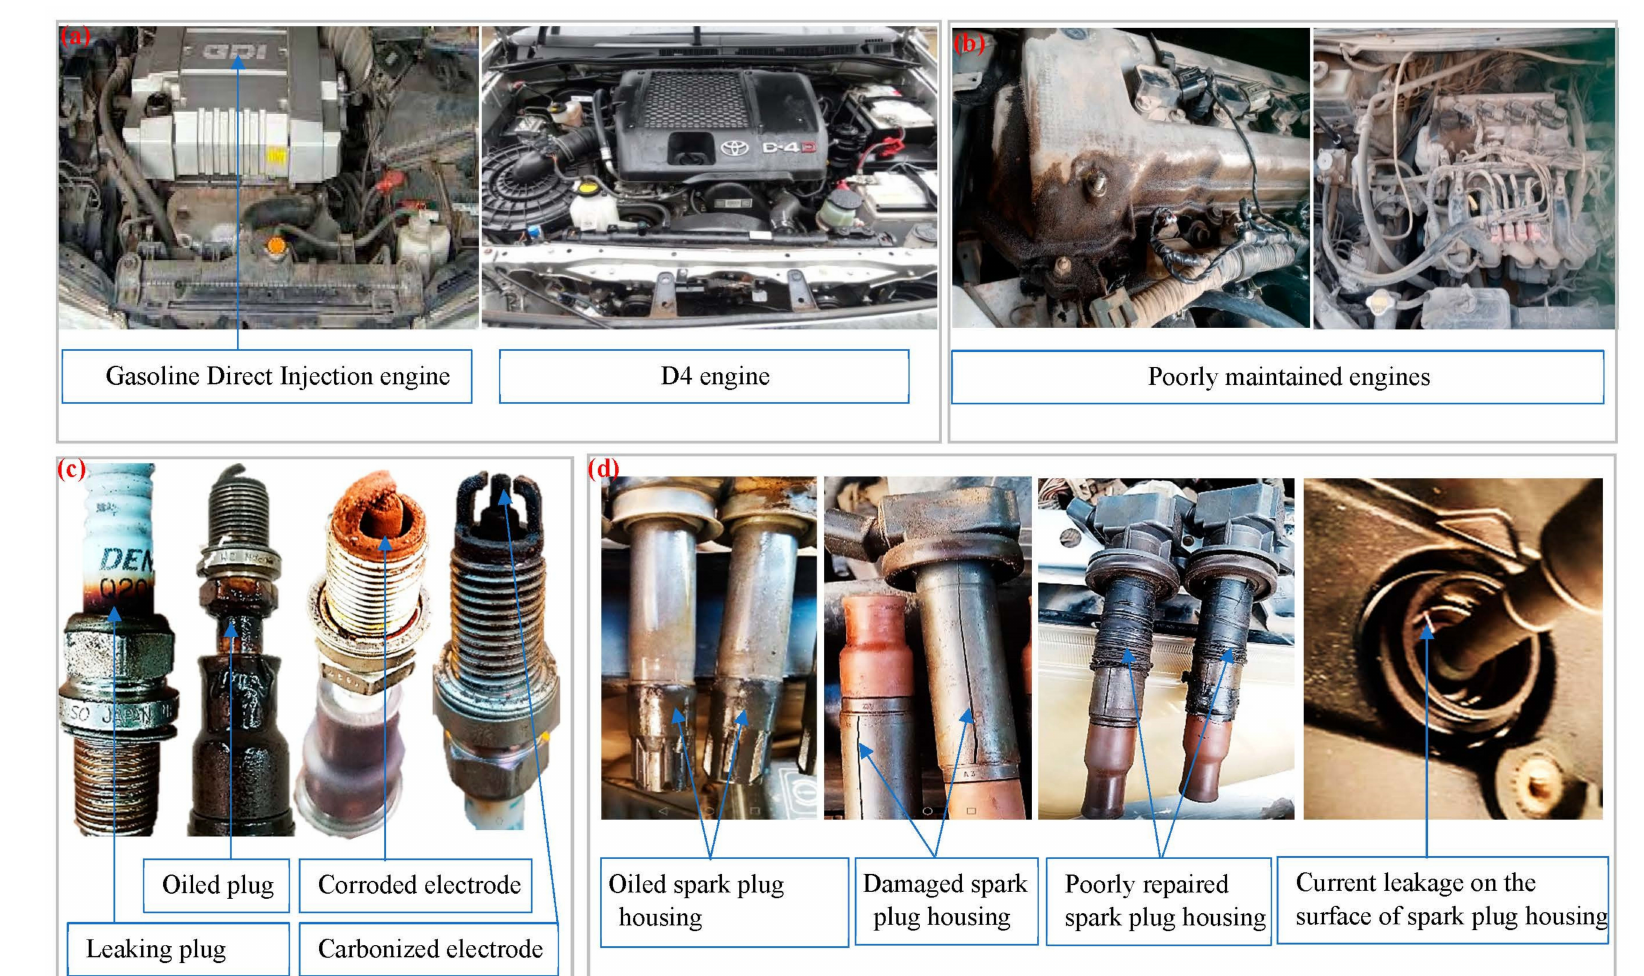
Figure 7. Some of the technical challenges found during inspection prior to the installation of CNG system in gasoline vehicles ( a ) incompatible engine technologies, ( b ) poorly maintained engines, ( c ) weakened spark plugs, and ( d ) weakened spark plug